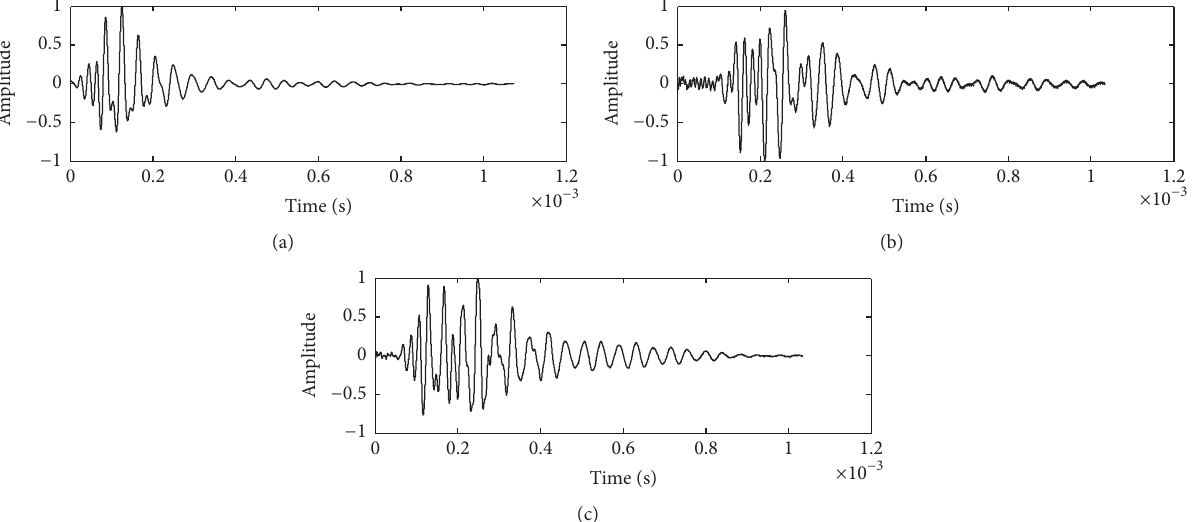
Figure 15: The GWs collected in the experiment: (a) no defect; (b) 30mm; and (c) 40 mm.